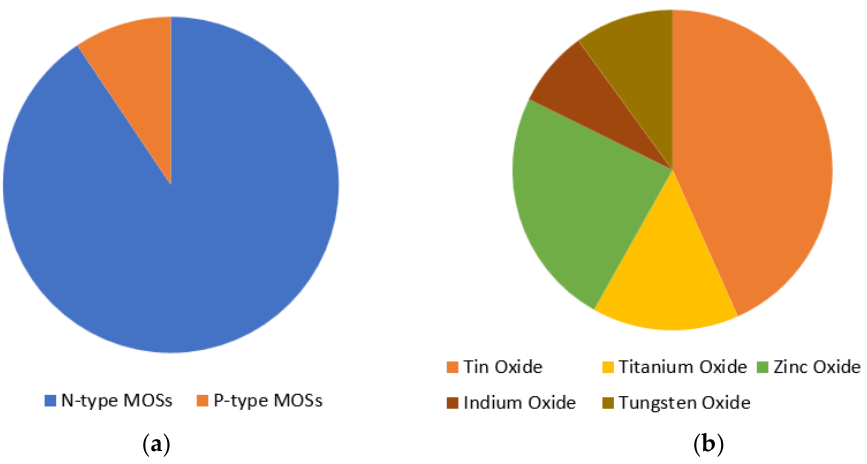
Figure 5. ( a ) Metal oxide semiconductors (MOSs); and ( b ) N-type MOSs, used for gas sensing.